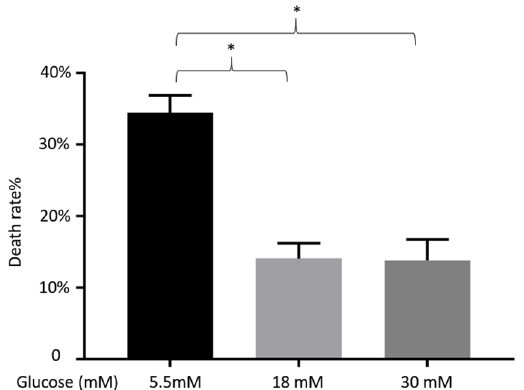
Figure 5. Effects on cell death rate of α -TC1-6 cells after 72 h incubation in 5.5, 18, or 30 mM glucose. Data are presented as the mean ± SEM of 24 samples per condition from three independent experiments. * p < 0.05.